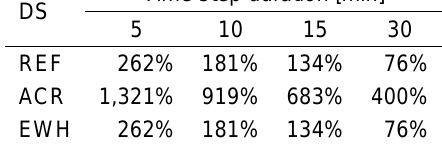
Table 9. Relative variation of the number of nonzero problem matrix coefficients caused by the removal of state variables for select DSs, by time step duration [variation relative to the same time step